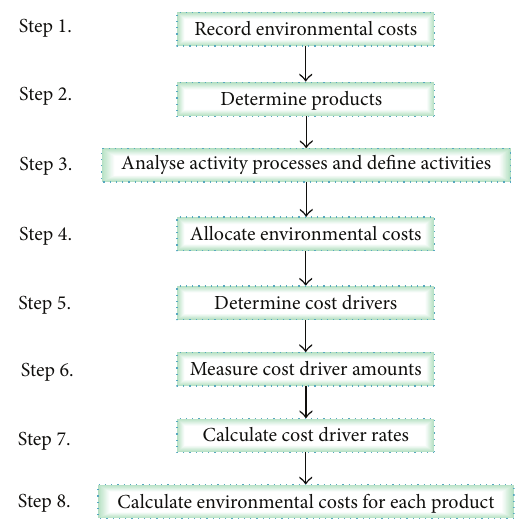
Figure 1: Obtain environmental costs for retrofitting transportation network in LSCP based on